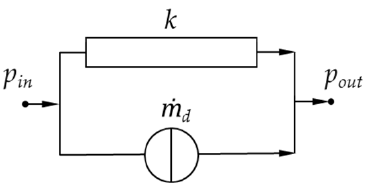
Figure 7. Basic network element for melt conveying.